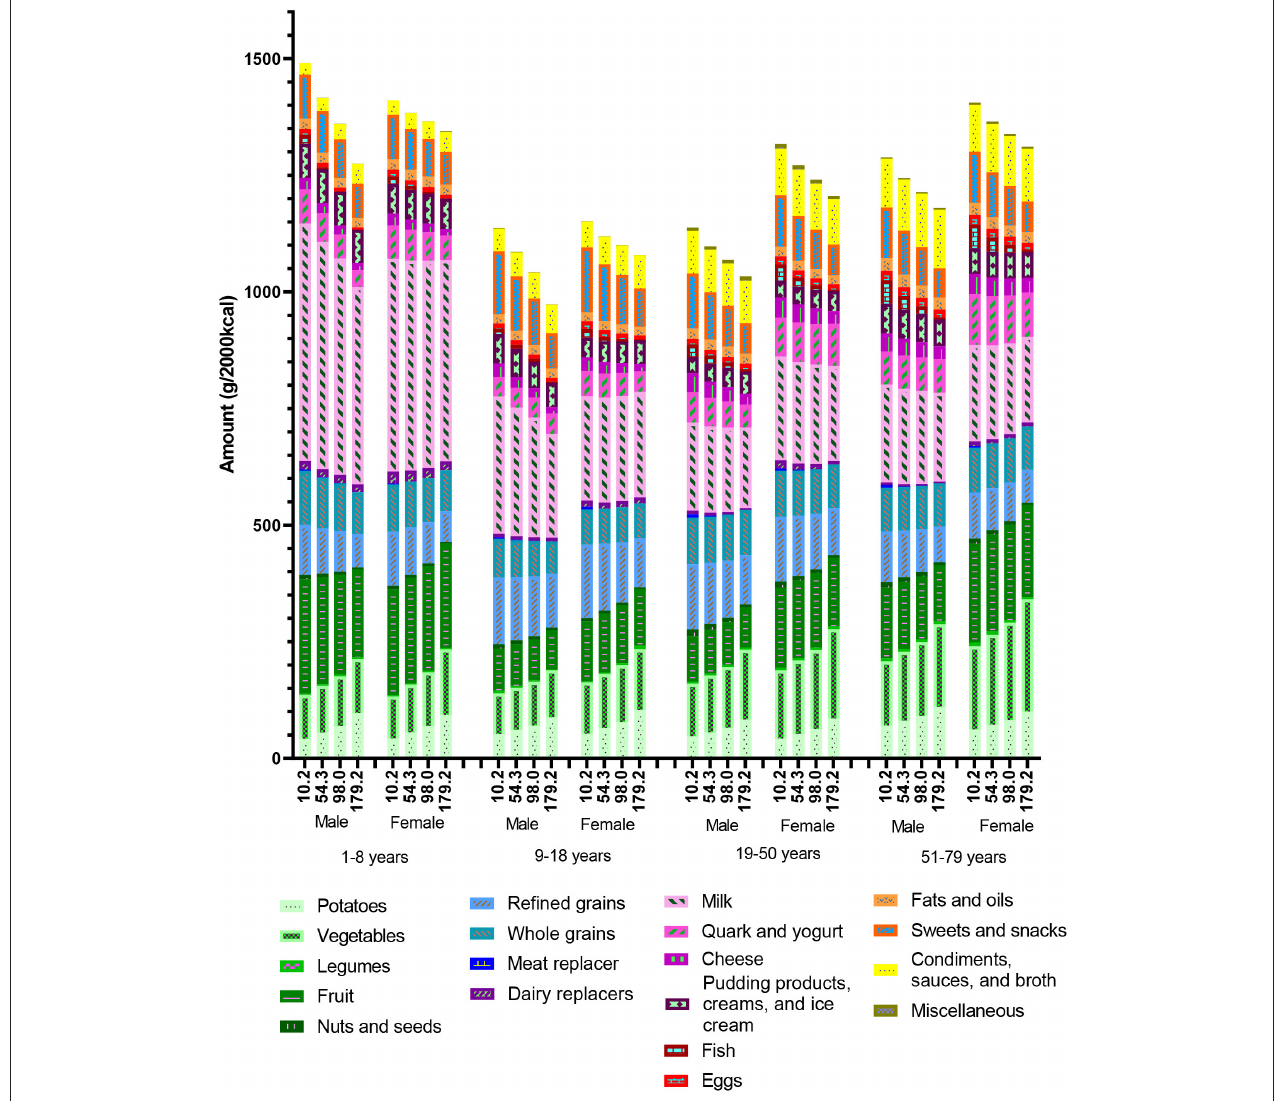
FIGURE 2 | Predicted quantity (g/2,000 kcal) per solid food group and milk, excluding other beverages and meat in the observed diets in the Dutch National Food Consumption Survey 2012–2016, presented by mean total meat consumption per quartile, gender, and age. Means and 95% confidence intervals on which this figure is based can be found in Supplementary Material 4